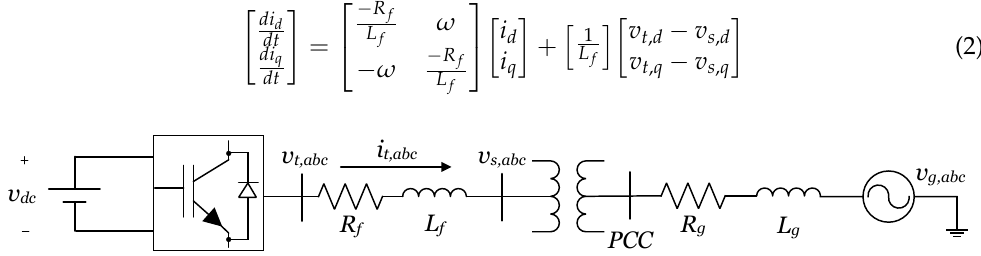
Figure 1. Single line representation of three-phase grid-connected